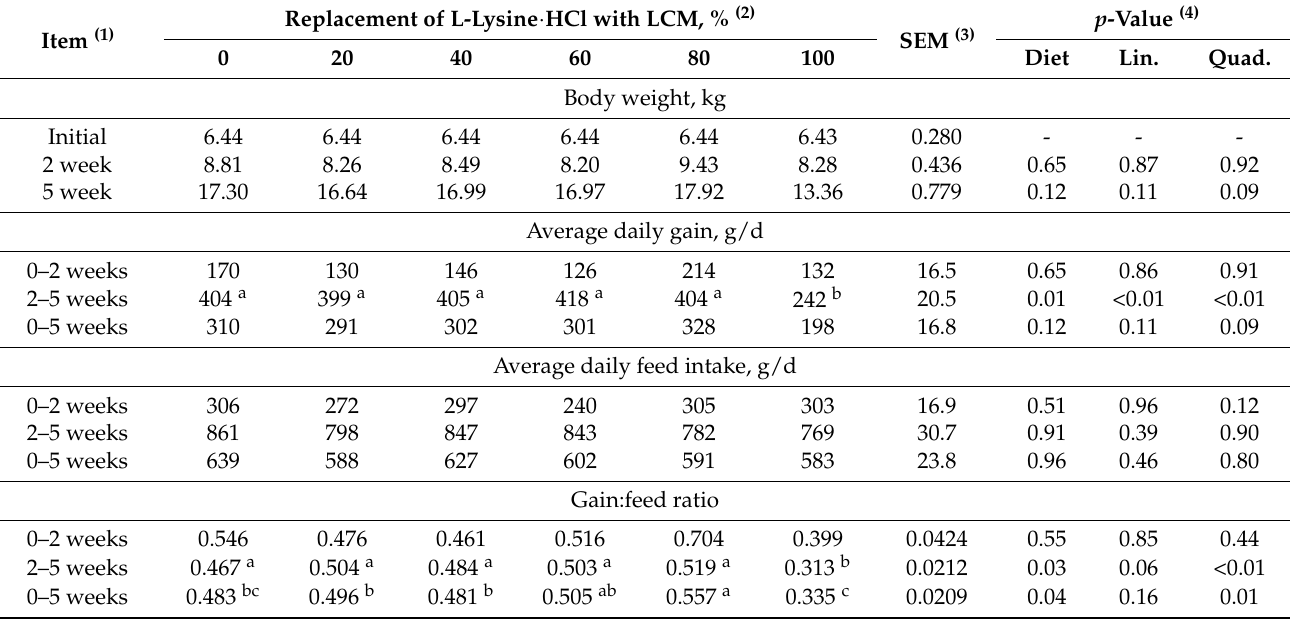
Table 9. Effects of LCM supplementation levels on growth performance in weaning pigs (exp. 2).